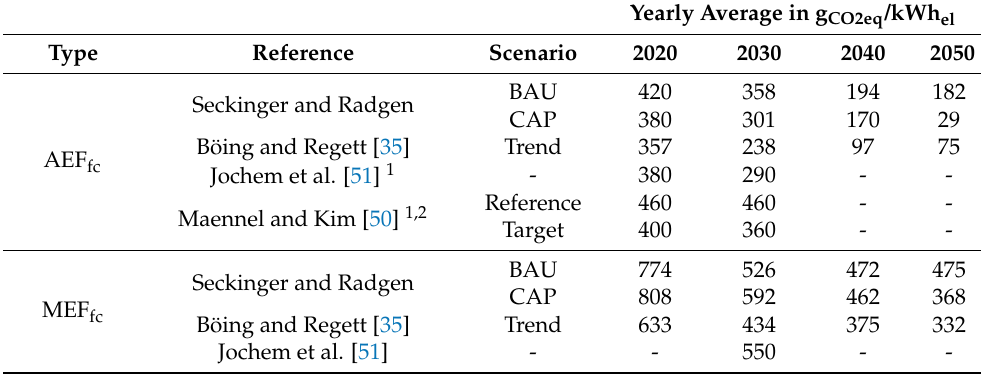
Table 3. Comparison of the AEF and MEF with other research examining prospective emission factors for